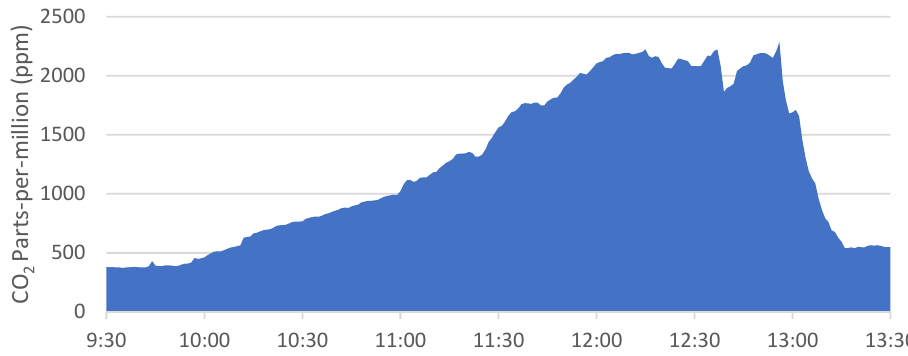
15 of 21 Figure 9. Test C: Power consumption, inside and outside temperature evolution over time. 3.2. Air Quality Field Tests In this section, the experimental results of the air quality tests are presented. Data were collected during several classes and days. Due to COVID-19 restrictions, presential attendance was lower than usual since the room capacity was limited. Nevertheless, the smart thermostat was able to be tested and operated at full functionality. 3.2.1. Test A